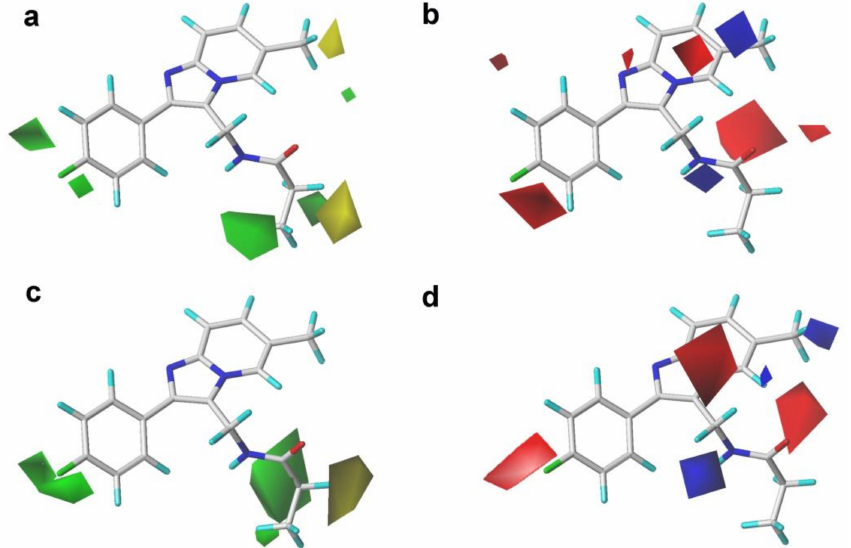
Figure 4. Contour maps of the steric and electrostatic fields of the CoMFA and CoMSIA models with compound 14 as a template. ( a ) The steric contour map of the CoMFA model; ( b ) the electrostatic con- tour map of the CoMFA model; ( c ) the steric contour map of the CoMSIA model; ( d ) the electrostatic contour map of the CoMSIA